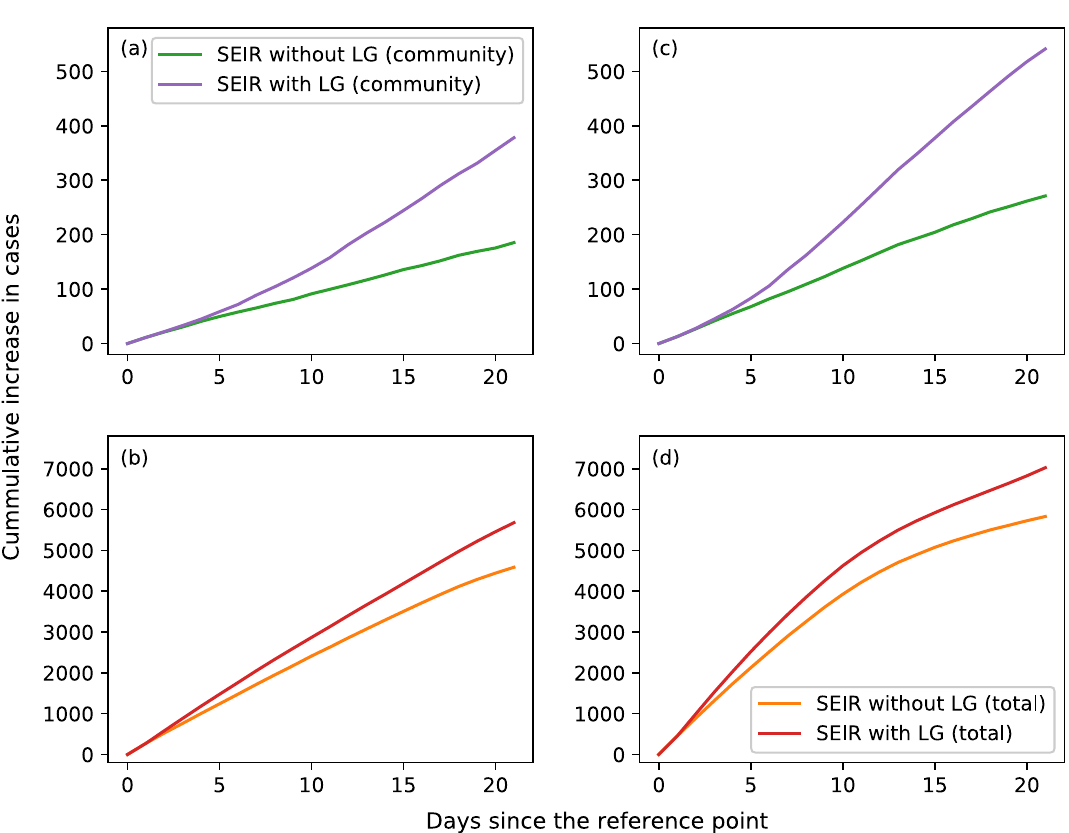
Figure 5. The cumulative increase in the number of new infection cases since the reference day. The two reference days are: 12 May for ( a ) and ( b ) after the outbreak has slowed down, and 21 April for ( c ) and ( d ) when the outbreak has reached its peak. The two curves in each subplot show the cumulative increase in new cases in the presence or absence of daily large-scale gathering (LG) for a population size of N = 1, 000, 000 . Subplots ( a ) and ( c ) illustrate the increase of new infection cases in the community, while subplots ( b ) and ( d ) indicate the total number of new infection